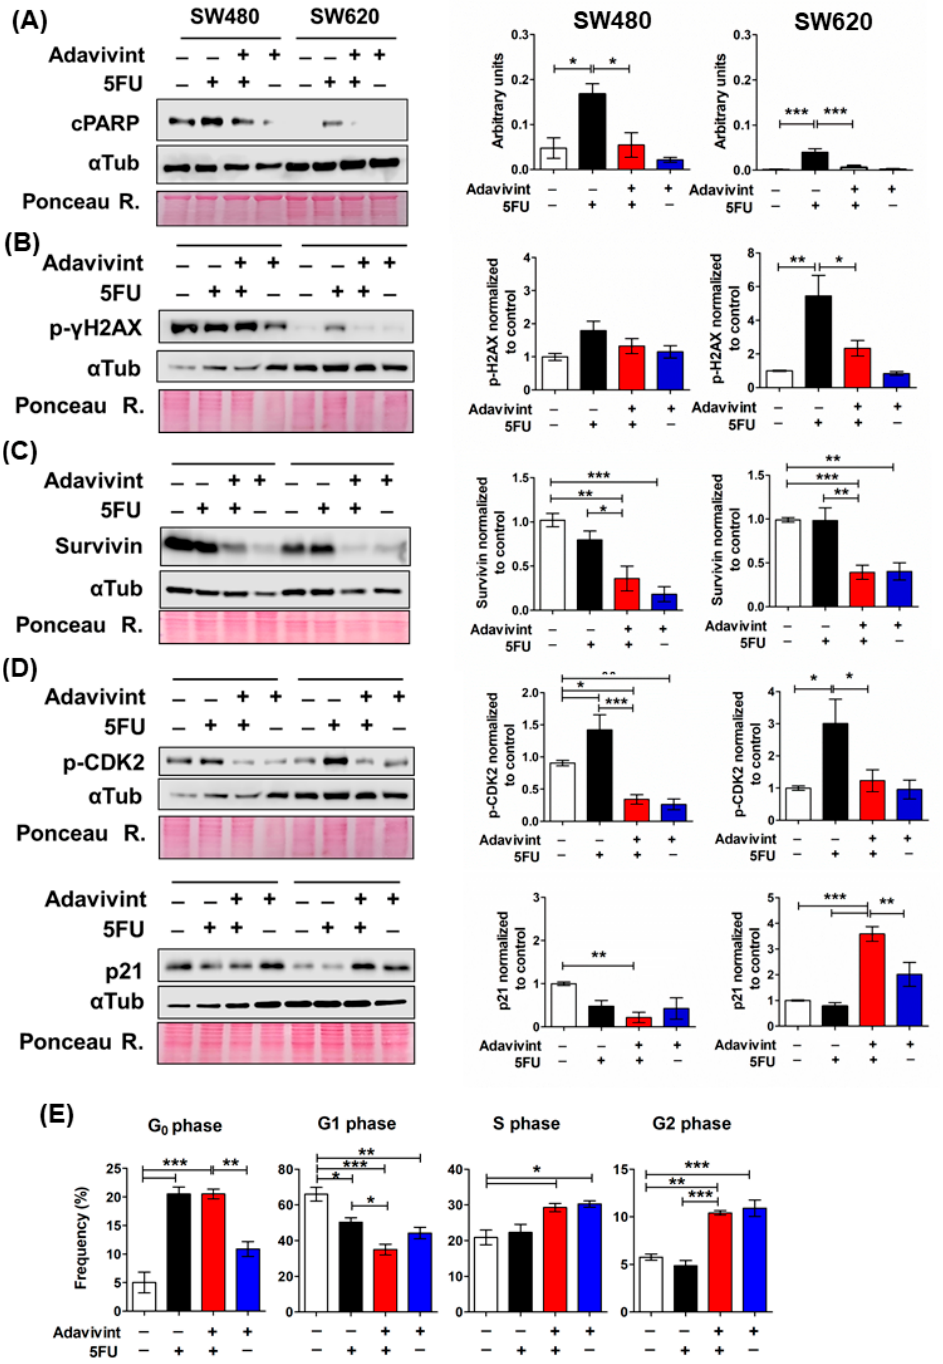
Figure 6. Canonical Wnt pathway inhibition in CRC spheroids increases 5FU resistance by de- creasing cell death and inducing cell cycle arrest. SW480 spheroids and SW620 spheroids were pre-treated with or without 1 µ M Adavivint for 72 h and subsequently with or without 5FU for 72 h. ( A – D ) Representative immunoblots of indicated proteins in SW480 spheroids and SW620 spheroids treated with the same conditions as described in ( A ). Ponceau red staining was used as a loading control ( left panels). Quantification of the relative levels of indicated proteins was nor- malized to control-treated with vehicles of Adavivint and 5FU ( right panels). ( E ) Cell cycle analysis of SW620 spheroids treated with the same conditions as described in ( A ). Data are represented by the mean ± SEM of at least three independent tests. One-way ANOVA followed by Bonferroni’s multiple comparisons; * p < 0.05; ** p < 0.001; *** p <